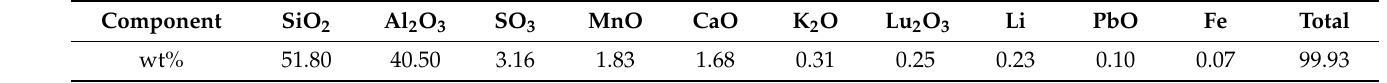
Table 1. Chemical composition analyses of